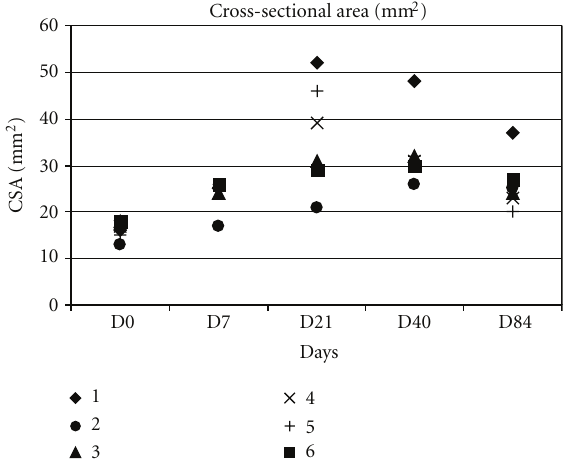
Figure 6: Change in CSA.